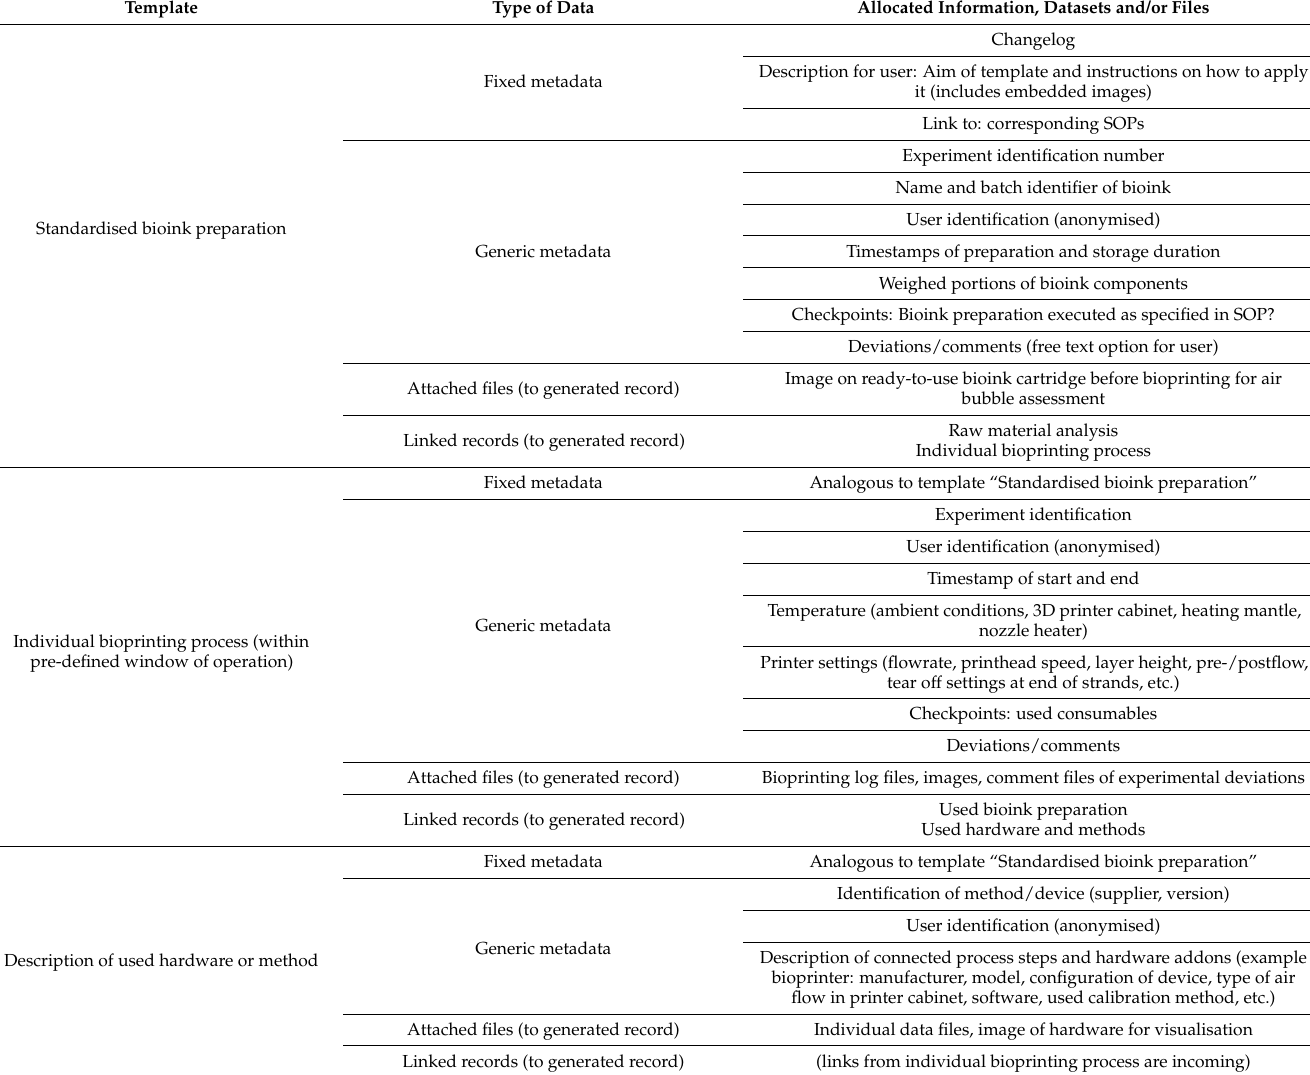
Table 2. Collected parameters for the bioink preparation and bioprinting process within one exper- imental run. Analogous to the process steps shown, the analytical process steps (which might be image data to describe the geometry or kinetic data on cellular metabolism) are connected to the description of the used devices, methods and consumables as well as the acquired assay raw data. Each enumeration in the column “Allocated information, datasets and/or files” can contain groups of generic